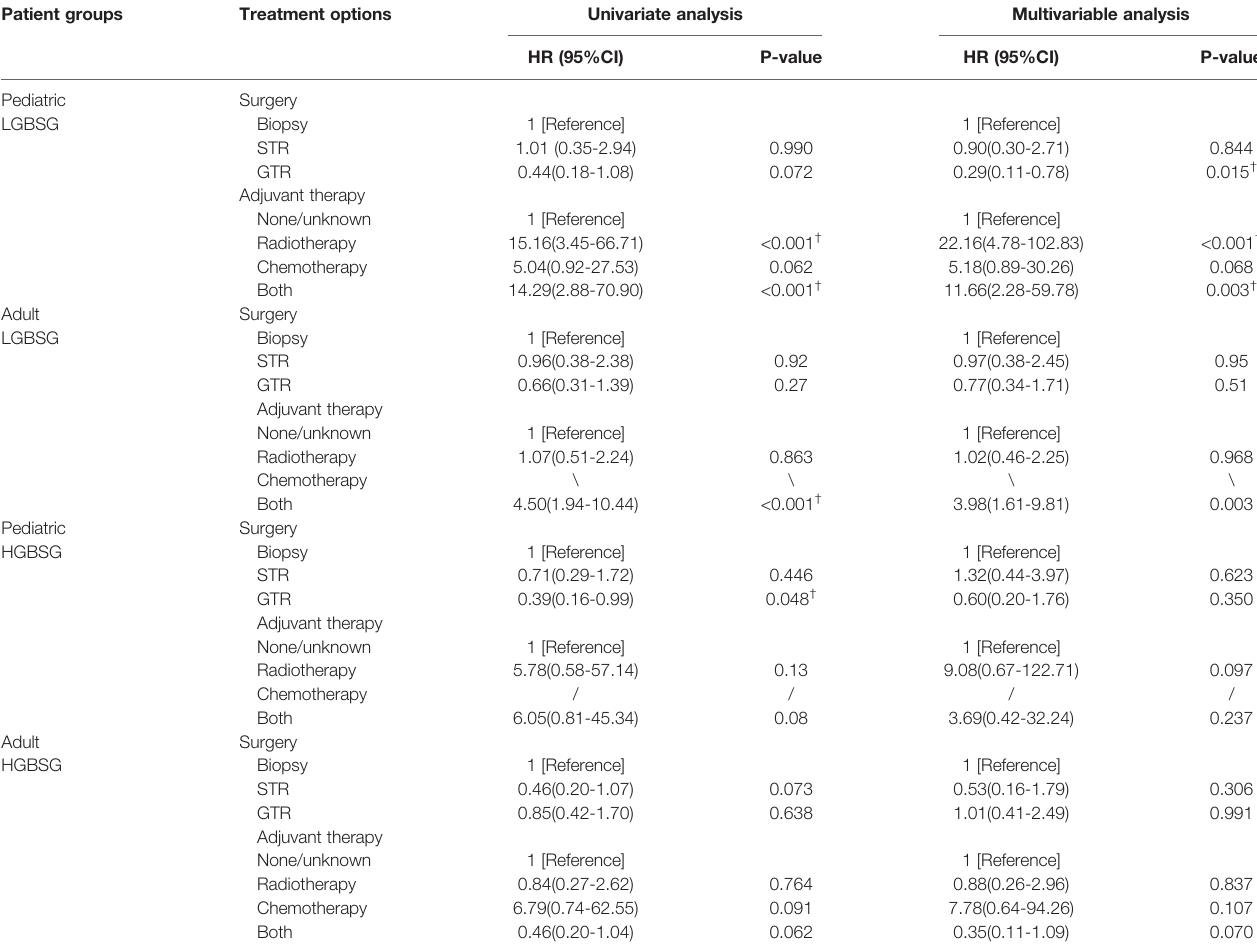
TABLE 2 | The result of univariate and multivariable analysis of extent of resection and adjuvant therapy in four different patient